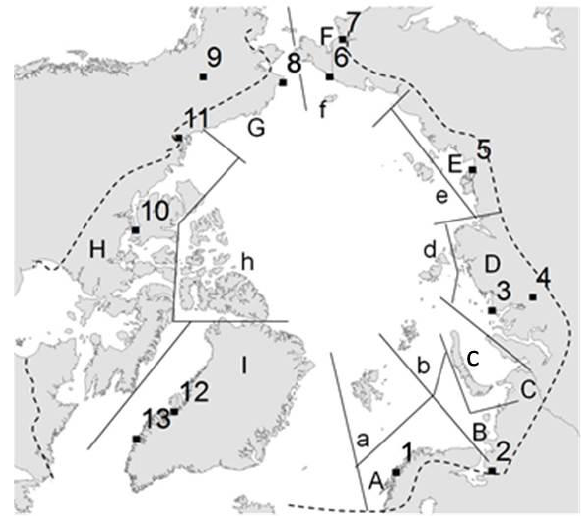
Capital letters define continental areas and lower case indicate Arctic islands